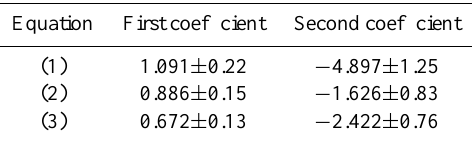
Table 3. The standard errors associated to the regressions (1–3)